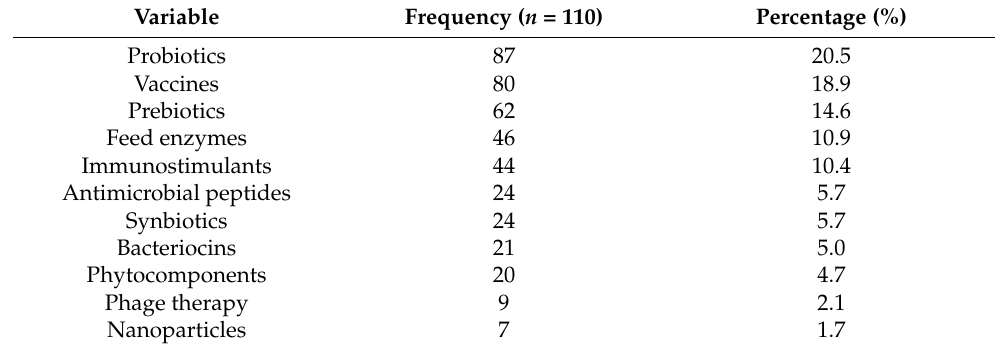
Table 6. Alternatives to